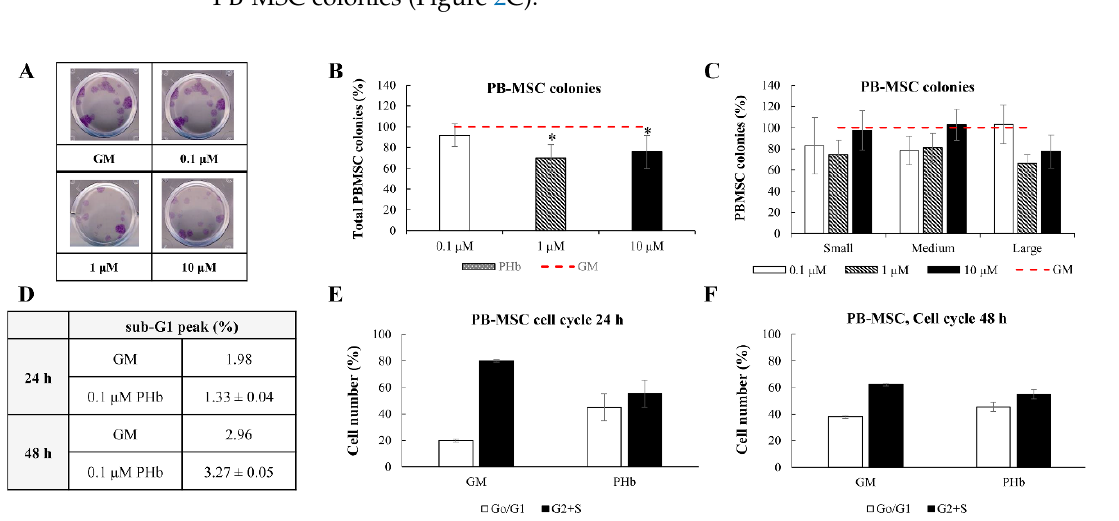
Figure 2. Acellular porcine hemoglobin (PHb) modulates clonogenic capacity and apoptosis of PB-MSCs. ( A ) Micrographs of CFU-F formed in growth medium (GM) or GM supplemented with PHb (magnification 40 × ). ( B ) Clonogenic capacity of PB-MSCs after 14 days in culture with GM supplemented with PHb, evaluated by CFU-F assay. The results are percentages of the corresponding control, where the number of CFU-F formed after culture in GM only was set at 100%. * p < 0.05, PHb compared to control. ( C ) Number of small (50–100 cells), medium (100–200 cells), and large (more than 200 cells) CFU-F colonies formed in GM supplemented with PHb. The results are expressed as in ( B ). ( D ) PHb does not affect the number of apoptotic PB-MSCs after 24 and 48 h in culture. ( E , F ) PHb changes percentage of PB-MSCs in G0/G1 and G2+S phase of the cell cycle in 24 ( E ) and 48 h ( F ) cultures. All the results are given as mean ± SD of three independent experiments.